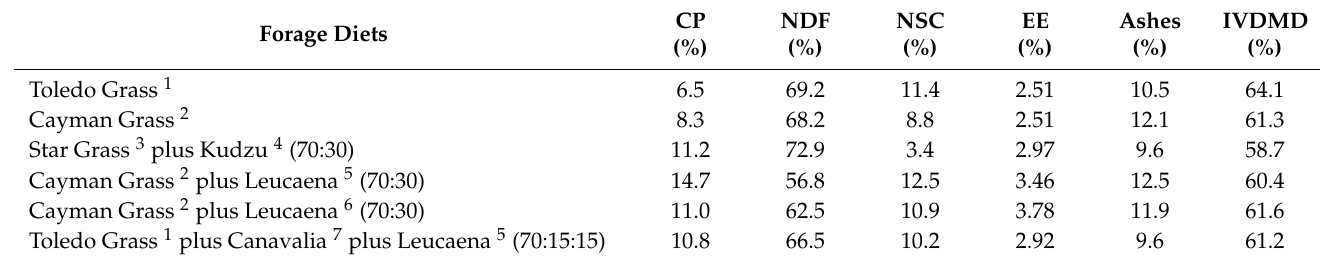
Table 1. Nutritional qualities of the forage diets used (as % of